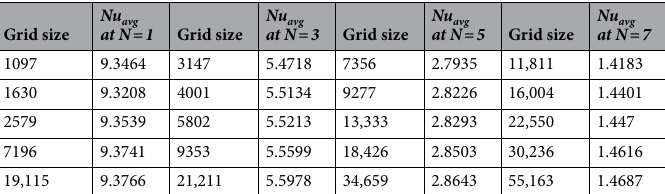
Table 2. Mesh independence Ra = 10 6 , Da = 10 –4 , ϕ = 0.01, ε = 0.6, and pr = 7.2.